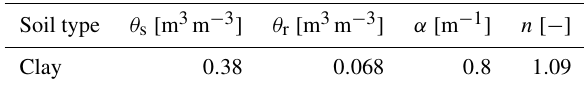
considering the surface energy budget. (a) The surface energy fluxes driving the simulation. The external fluxes, incoming shortwave and longwave radiation, and the latent heat flux are computed with ex- isting GEOframe components. (b) The thermal regime of the up- permost 2m of the soil column. As can be seen, during winter the temperature of the uppermost layer goes below 0 ◦ C, and the grey line is the 0 ◦ C isotherm; therefore, it is not reasonable to overlook the phase change of water. Table D1. Parameters of the SFC